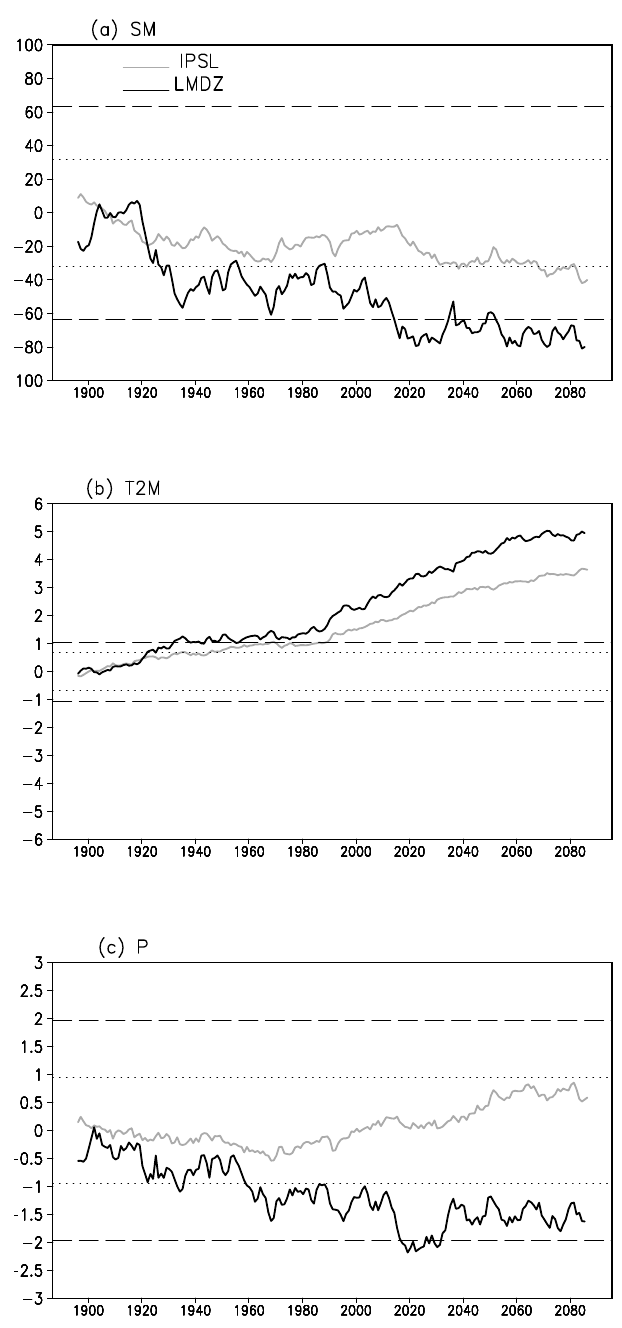
Figure 10. Time series of area-averaged anomalies of (a) soil mois- ture (SM; mm), (b) 2m air temperature (T2M; ◦ C) and (c) pre- cipitation (P; mmd − 1 ) from ALL (HIST and RCP) experiments of (grey) IPSL and (black) LMDZ for the region 74.5–86.5 ◦ E; 16.5– 26.5 ◦ N. The yearly JJAS anomalies are computed as the difference from the corresponding long-term mean (1886-2005) of NAT inte- gration. Each time series has been smoothed by a 20-year running mean. The two horizontal dashed lines denote 1standard deviation limits from the NAT integration computed from the yearly JJAS av- erages for LMDZ and dotted lines correspond to